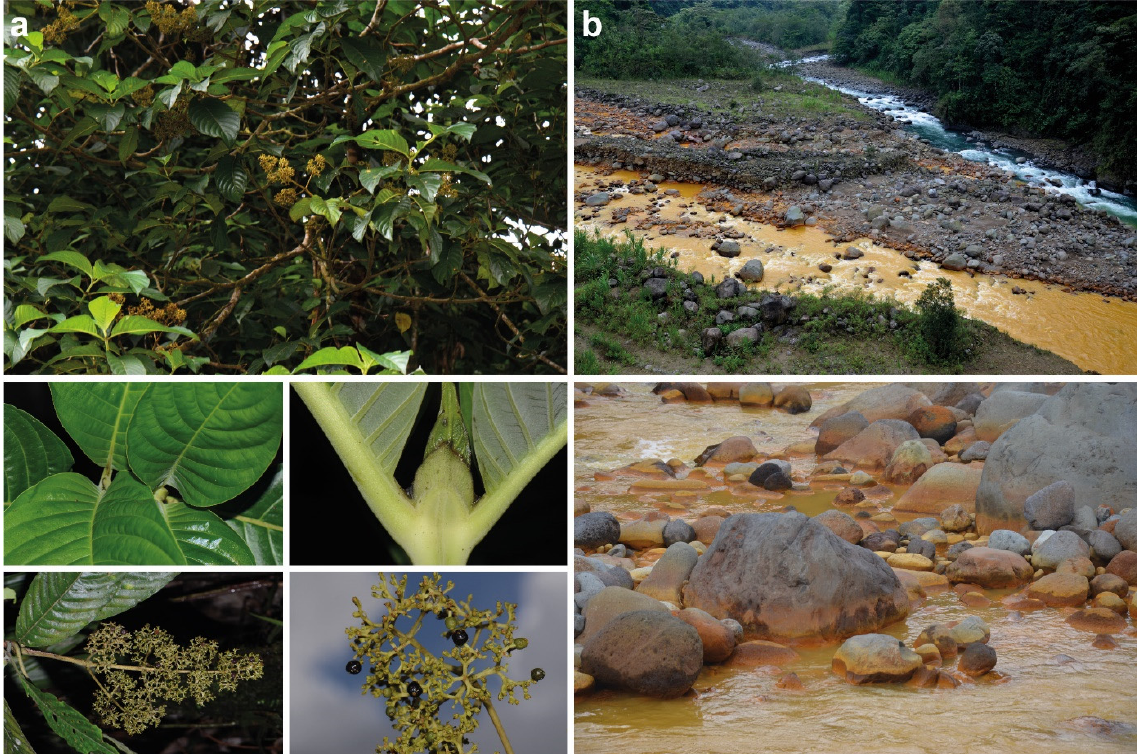
Figure 1. ( a ) Habitus, leaves, stipules and infructescence with fruits of Palicourea luxurians (Rubiaceae: Palicoureeae) growing on the steep riverbanks of Río Sucio; ( b ) Confluence of Río Sucio (brownish-yellowish, foreground) and Río Honduras (blue, background) near the bridge of Route 32 through pristine Braulio Carrillo National Park. The color of the river indicates deposits of schwertmannite, a yellowish-brownish sulfate containing iron oxide [27]. All photos: A. Berger.